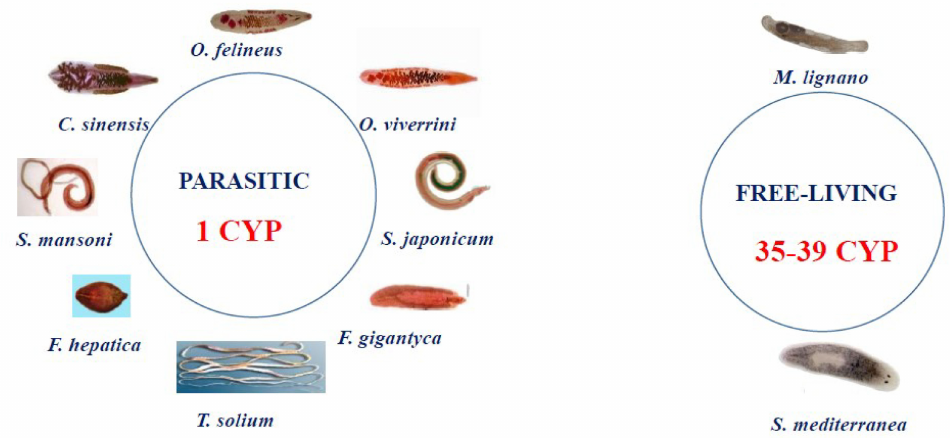
Figure 1. In silico data: composition of the CYPome in Platyhelminthes. Only one CYP gene has been found in all known parasitic flatworms. The following sequences were analyzed: S.